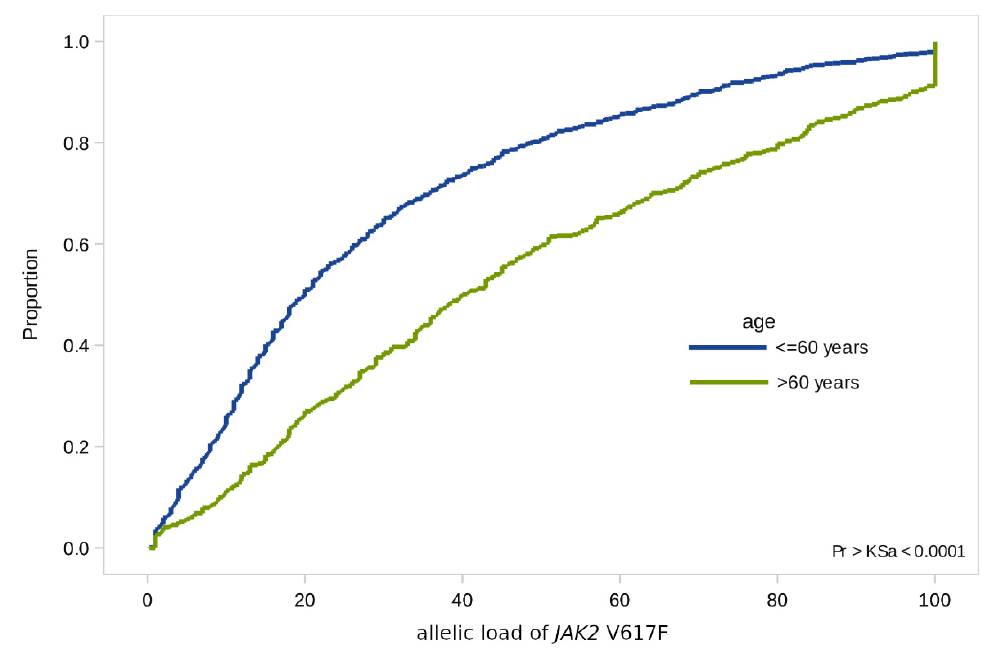
Figure 2. Empirical distributions of JAK2 V617F allele load in patients of two age groups: Under 60 and over 60. Table 2. Statistical parameters of JAK2 + and CALR + allelic loads by main demographic factors. Comparison of means by one-way analysis of variance (ANOVA), p -value from Fisher’s test was used to estimate significance.